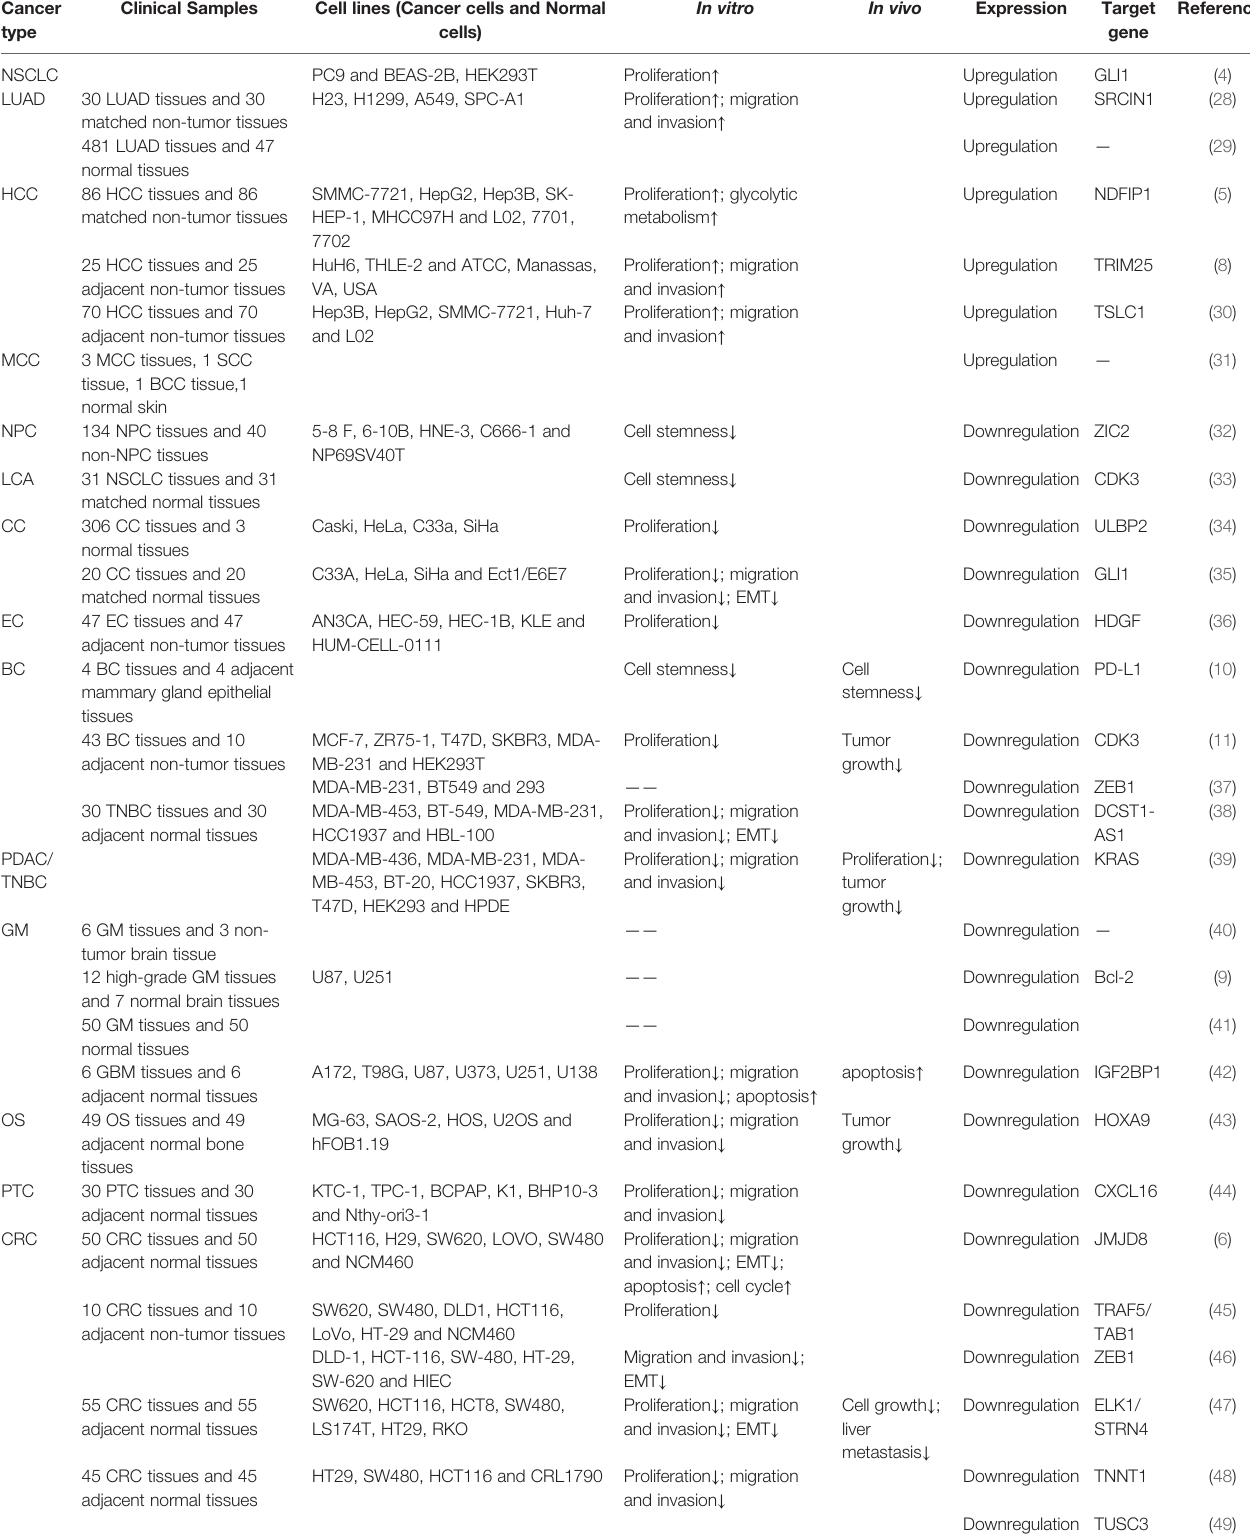
TABLE 1 | miR-873-5p dysregulation and its target genes in